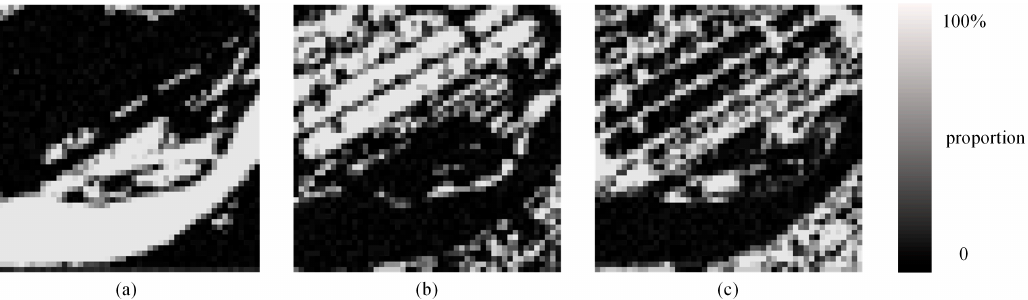
Figure 14. Proportional images of three classes with a 10% error in the proportional image ( S = 8). ( a ) Water, ( b ) vegetation, ( c ) soil.